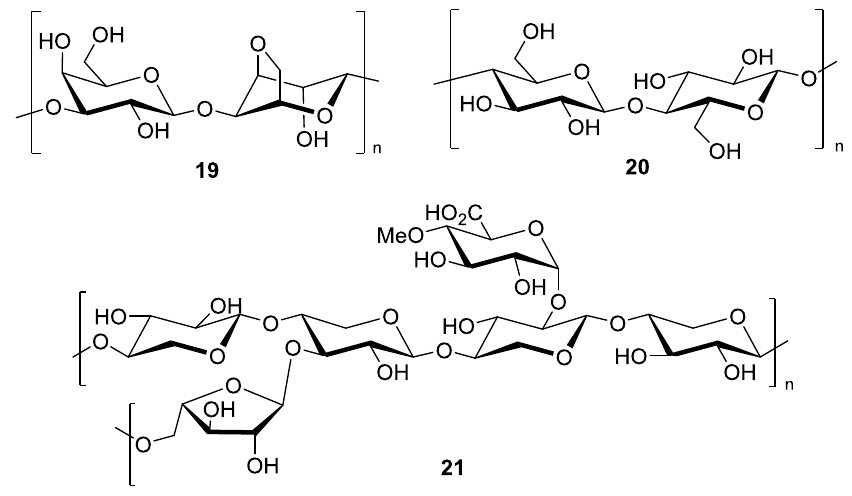
Figure 7. Polysaccharides used for supporting PdNPs catalyzing the Sonogashira cross-coupling